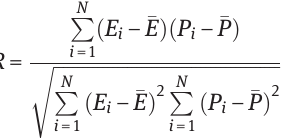
stress data from the constitutive equation can track the experimental data of BFe10-1-2 cupronickel alloy throughout the entire temperature and strain rate range. Only under some deformation conditions (i. e. 1,123K in 1s − 1 , and 1,173K in 10s − 1 ), an obvious variation between experimental and computed flow stress data can be observed.